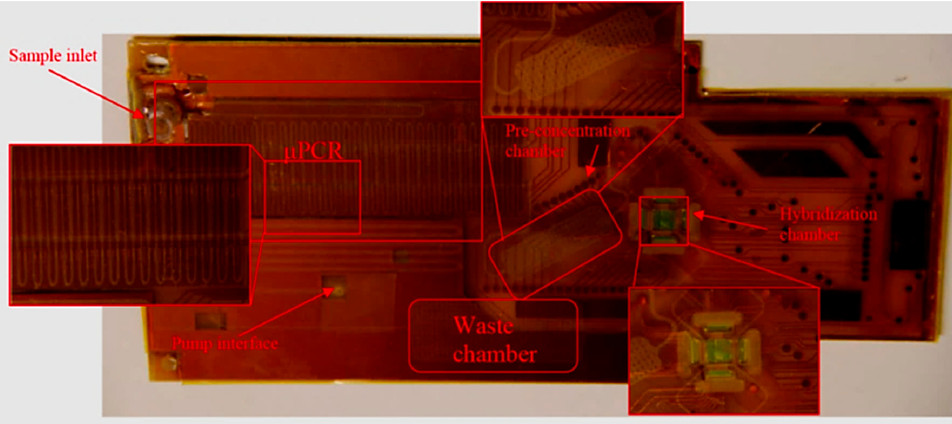
Figure 22. Photograph of the fabricated PCR-on-chip device. (Re-printed from Moschou et al. [154]. Copyright (2013), with permission from Society of Photo-Optical Instrumentation Engineers (SPIE)).